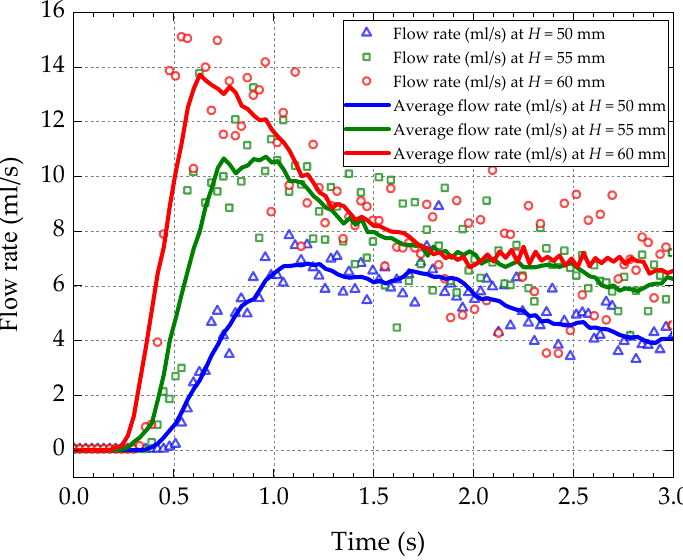
Figure 13. Change rules of flow rate moment versus time (Monitoring Plane 2). As for the fluid field characteristics of the interlocking pore near the bottom, it can be obtained by Monitoring Plane 3 with time, as shown in Figure 14. The flow rate tends to be stable after a fleeting fluctuation. A higher oil level brings a greater fluctuation before 1.5 s, as well as a greater flow rate after 1.5 s. Furthermore, the flow rate and its corresponding time integral (oil volume) flowing through Monitoring Plane 1 are shown in Figure 15. The curves of oil volume at oil levels 55 mm and 60 mm have similar trends and slopes, whereas at 50 mm, the oil volume grows more slowly, and the total oil volume is significantly lower than other high oil levels. Time (s) Figure 14. Change rules of flow rate moment versus time (Monitoring Plane 3).